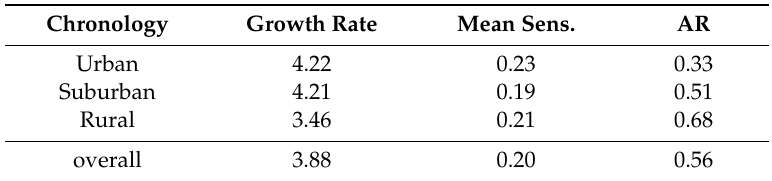
Table 5. Mean radius growth rate [mm / yr], mean sensitivity and autocorrelation (autoregressive, AR) of urban, suburban and rural chronologies, as well as for the overall mean chronology of A. sachalinensis in Sapporo, Japan for their total period of growth.